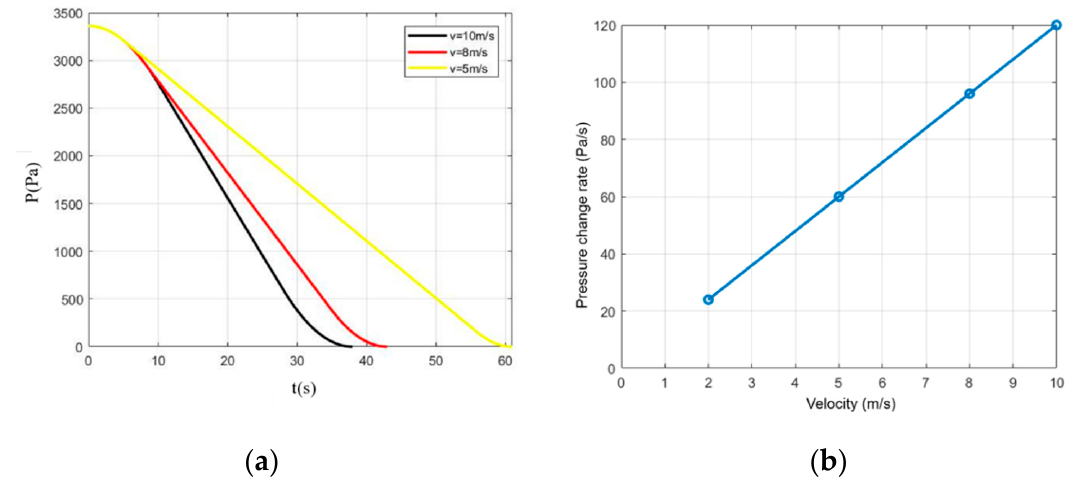
Figure 12. Influence of the elevator running speed on the air pressure change inside the car. ( a ) On the air pressure change value amplitude. ( b ) On the air pressure change rate.